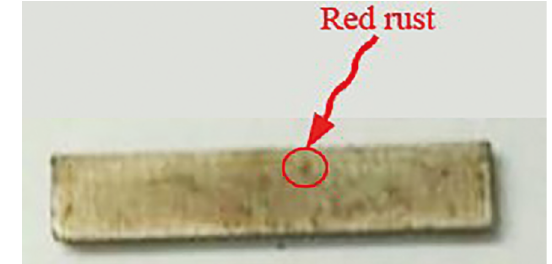
Figure 7. Adhesion test of Ni/nano-Al liner specimen.